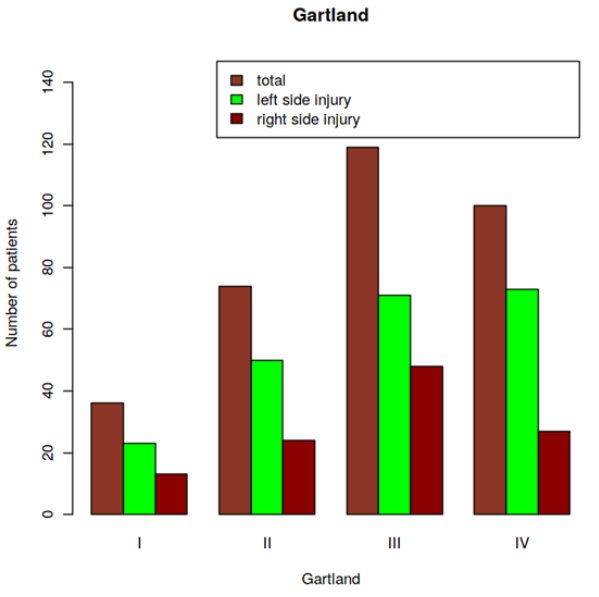
Figure 3. Number of patients per fracture laterality and Gartland type.